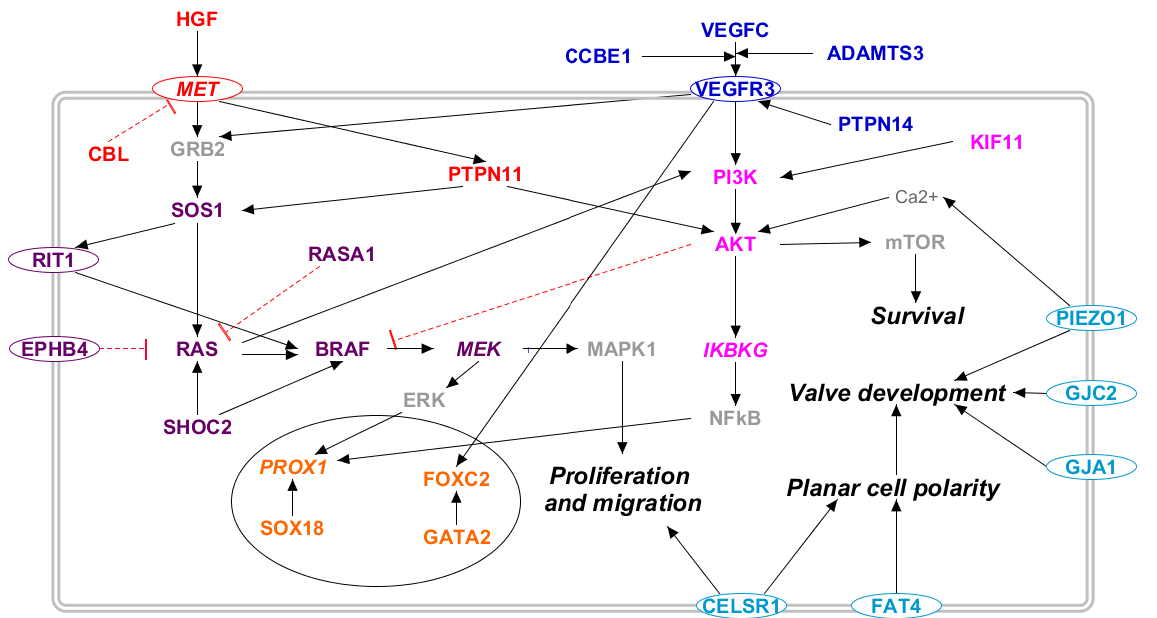
Figure 2. Molecular pathways involved in primary lymphedema. The 28 proteins coded by the genes related to primary lymphedema are placed along known molecular pathways in a somatic cell: RAS/MAPK (violet), PI3K/AKT (lilac), VEGF-C/VEGFR-3 (blue), and HGF/MET (red). The transcription factors are marked in orange, and the light blue proteins are those whose outcome is known, i.e., altered lymphatic valve formation, but the molecular pathway is uncertain. Proteins not encoded by either diagnostic or candidate genes are marked in grey. Proteins encoded by candidate genes are reported in italic. When circled, the protein is a membrane protein. Black arrows represent a positive interaction, while red T-bars represent an inhibition.